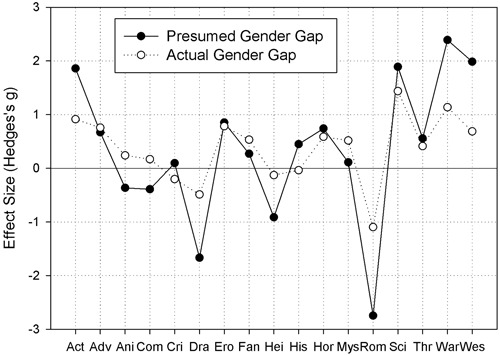
Black points show the effect sizes (Hedges’s g) of the presumed gender gap in movie preferences as observed in Study 1. Negative values indicate a stronger presumed female preference for a genre, whereas positive values indicate a stronger presumed male preference. White points show the effect sizes (Hedges’s g) of the actual gender gap in movie preferences as observed in Study 2. Negative values indicate a stronger female preference for a genre, whereas positive values indicate a stronger male preference. Short-hands on the x-axis are the same as in Figure 1